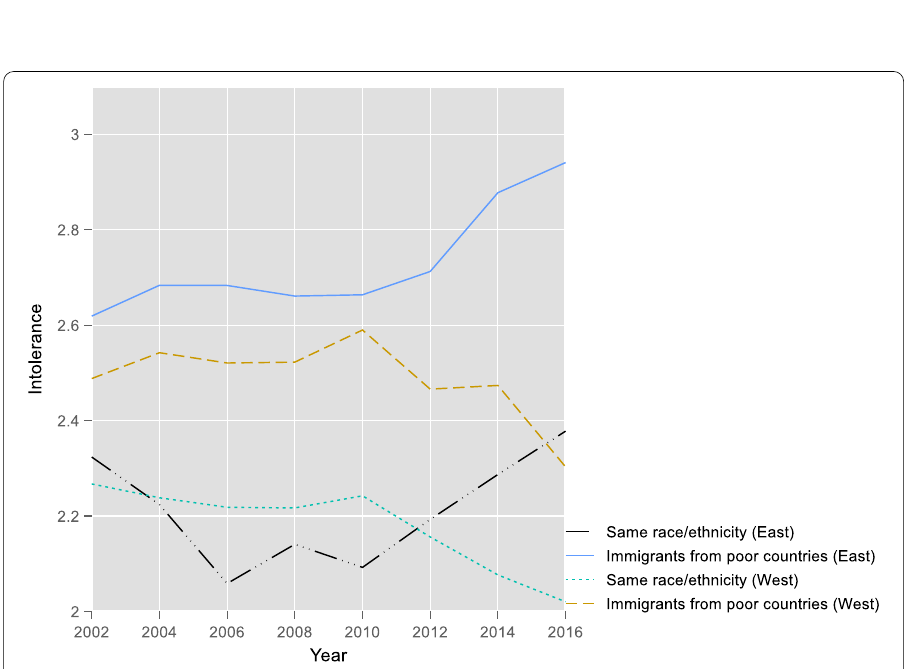
Fig. 7 Time trends for attitudes towards immigrants of the same race towards immigrants from poor countries outside of Europe. Data from European Social